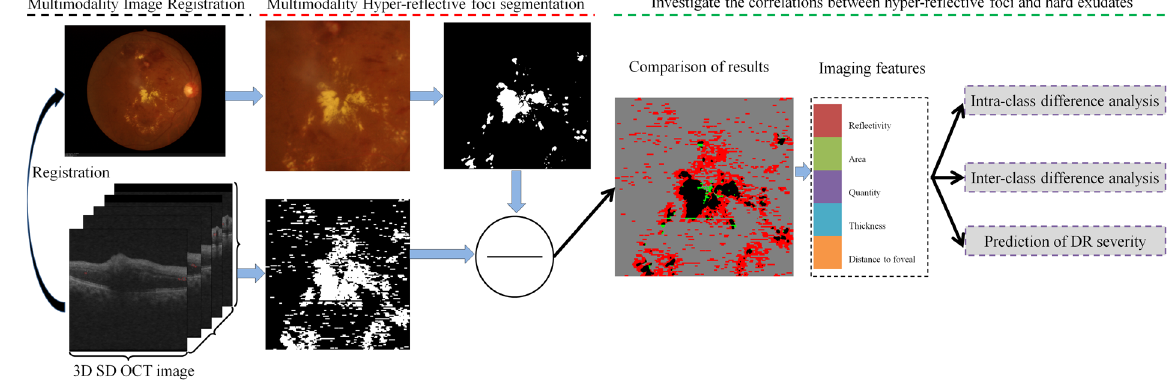
Figure 1. Diagram showing the processing pipeline of our multimodality analysis